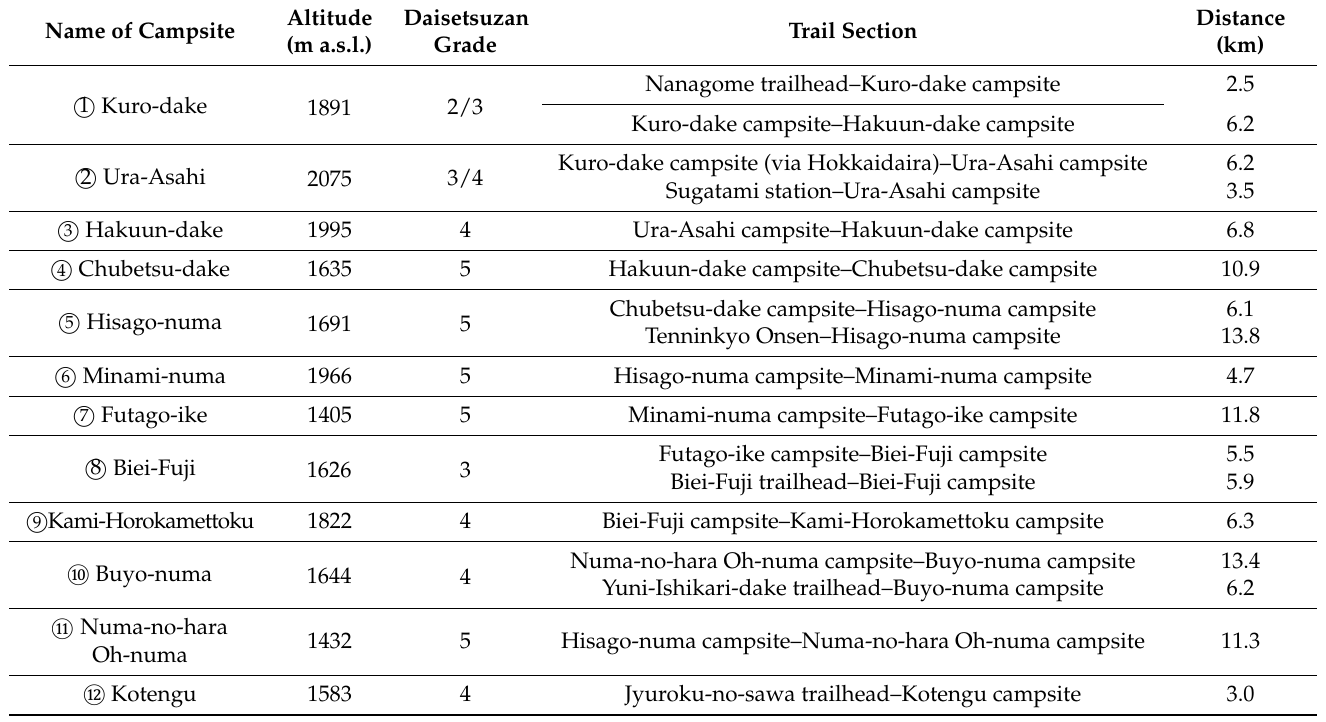
: Corresponding to the number shown in Figure 1. The average distance between adjacent campsites (two of which are attached to accom- modation huts) is 7.3 km for the 12 campsites in Daisetsuzan National Park (Figure 1).